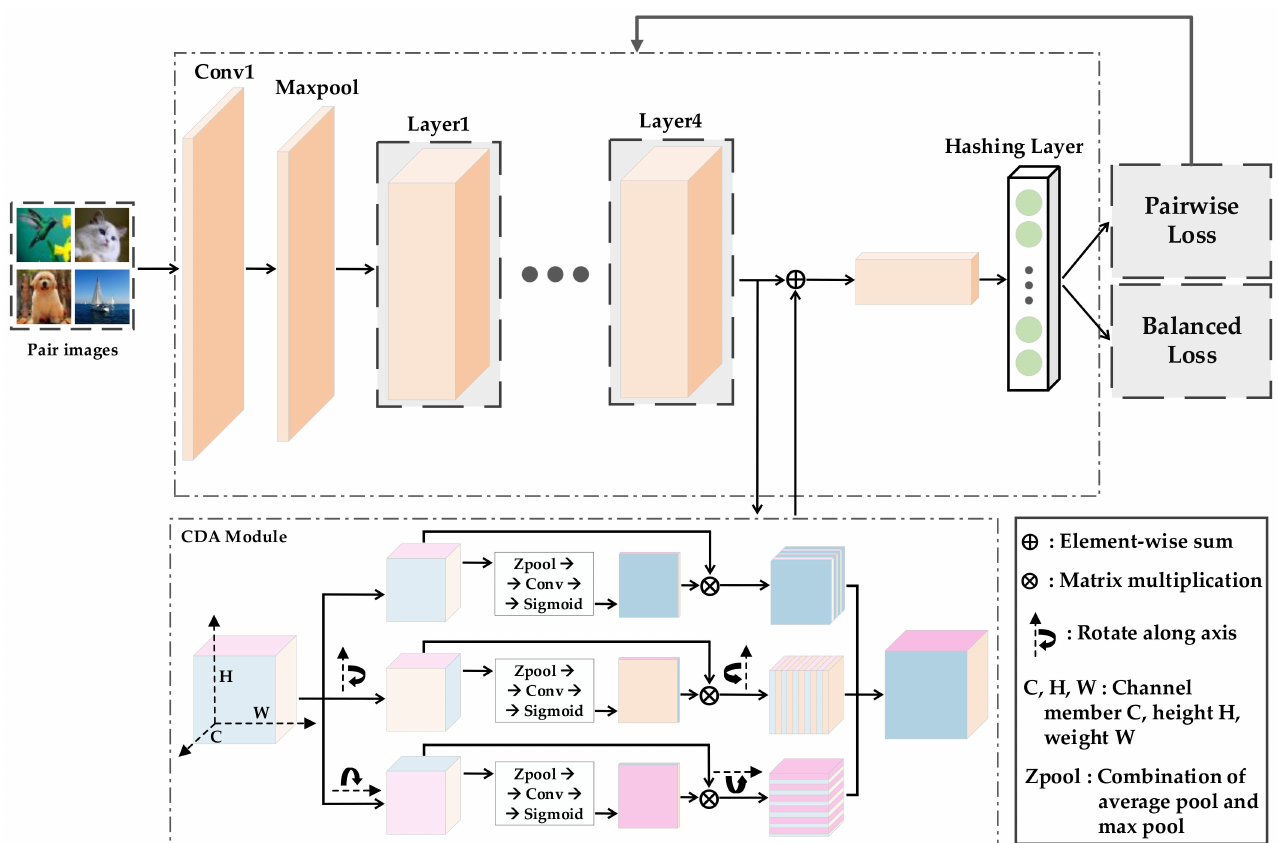
Figure 1. The overall framework of DCDAH is shown below: The framework accepts pair images as the input, and features of images are extracted via ResNet18. For feature maps that are captured after Layer4, DCDAH inputs them to the CDA module, the attention weight is distributed by CDA, and the feature maps are multiplied by weight. Finally, the weighted feature maps generate hash code through the hash layer, and parameters are optimized by two loss